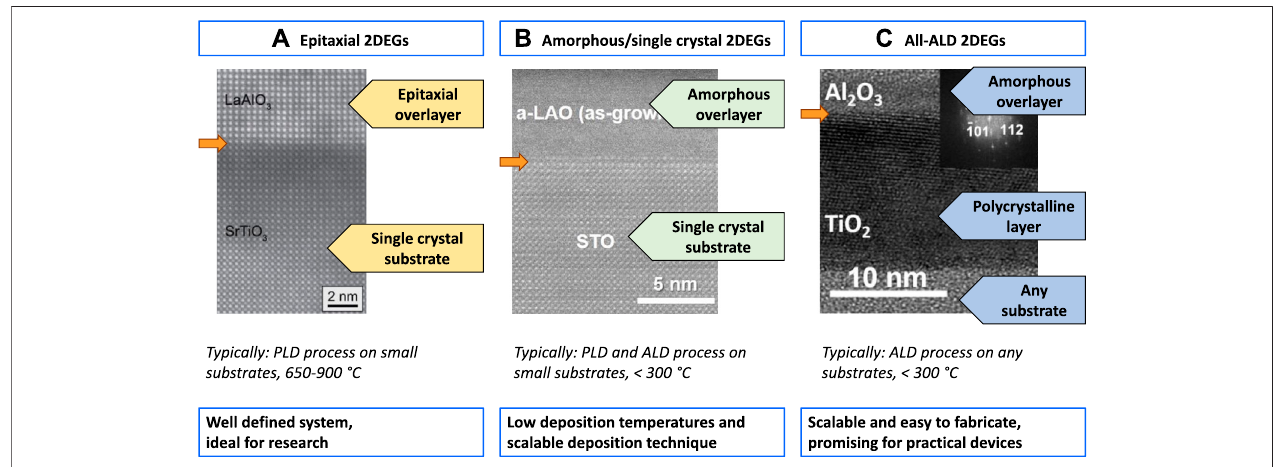
FIGURE1| Three different2DEGsmaterial systemsat oxideinterfacesof (A) Epitaxial2DEGs[2], (B) amorphous oxideonsinglecrystaloxidesubstrates [62],and (C) All-ALD 2DEGs [32]. The orange arrows indicate the position of the conductive oxide interfaces.